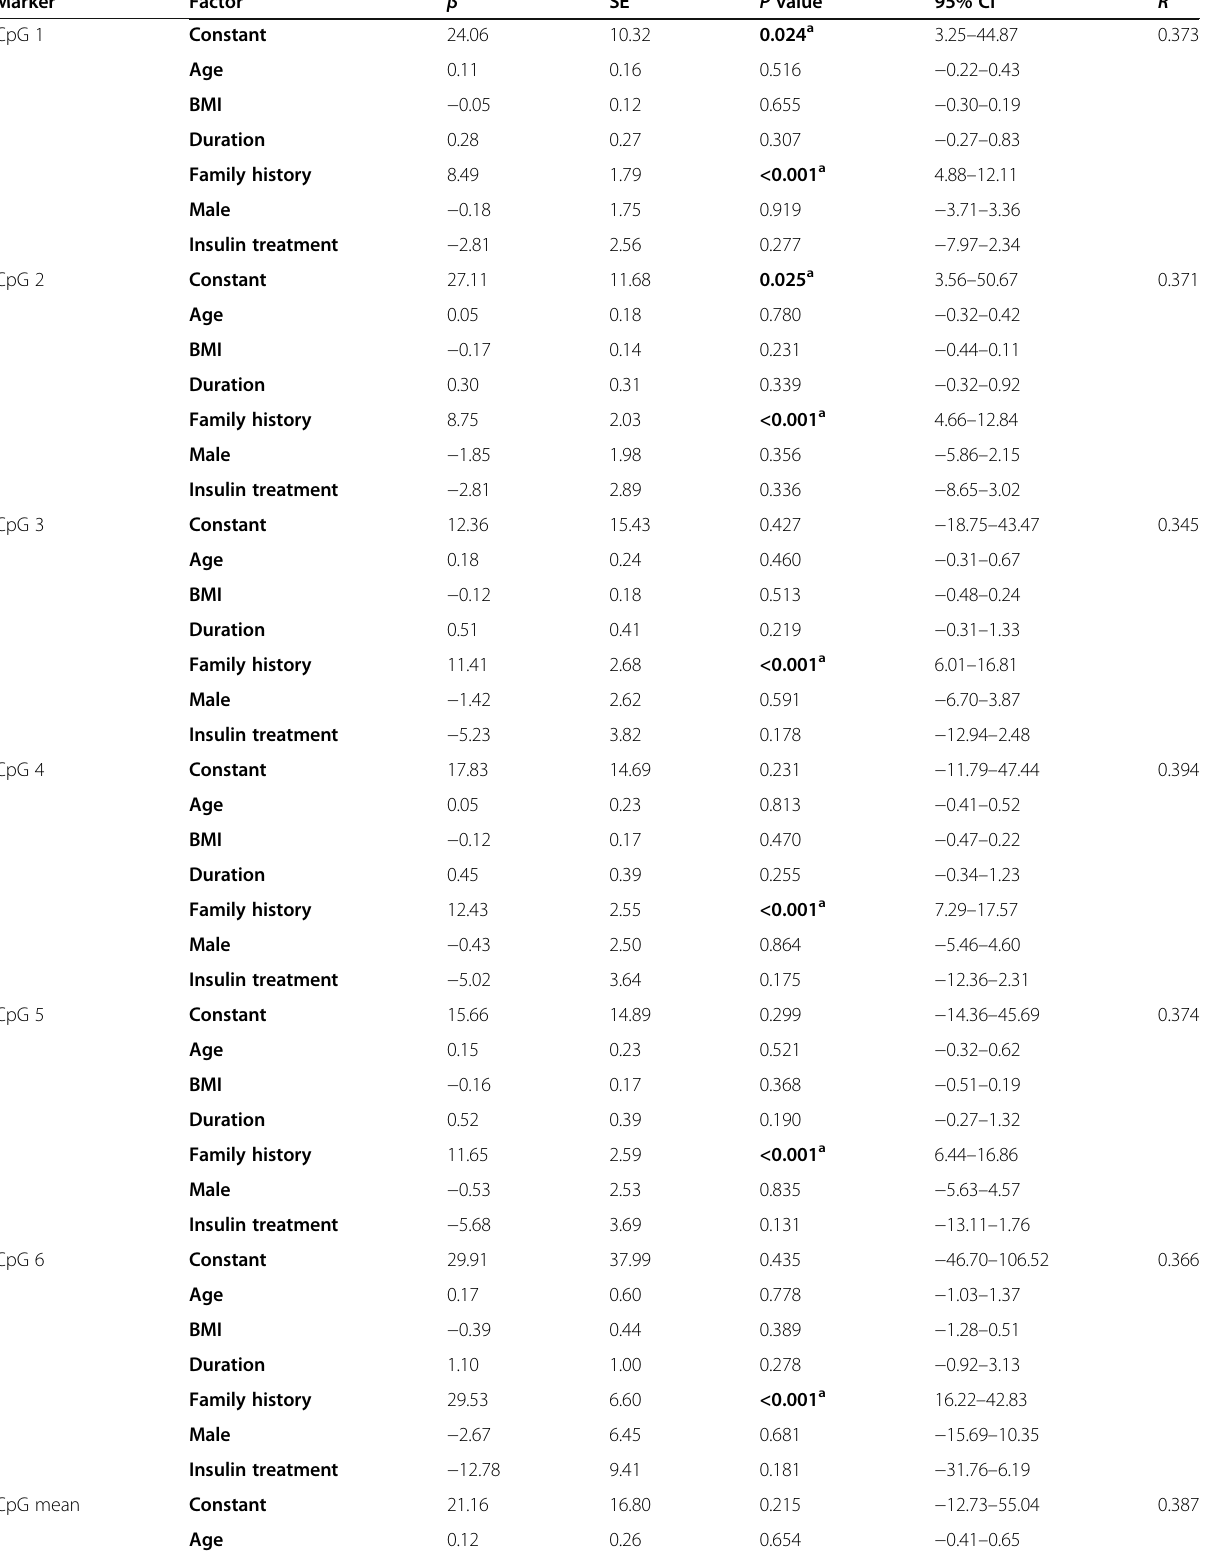
Table 4 Linear regression for factors affecting methylation in the T2D patients